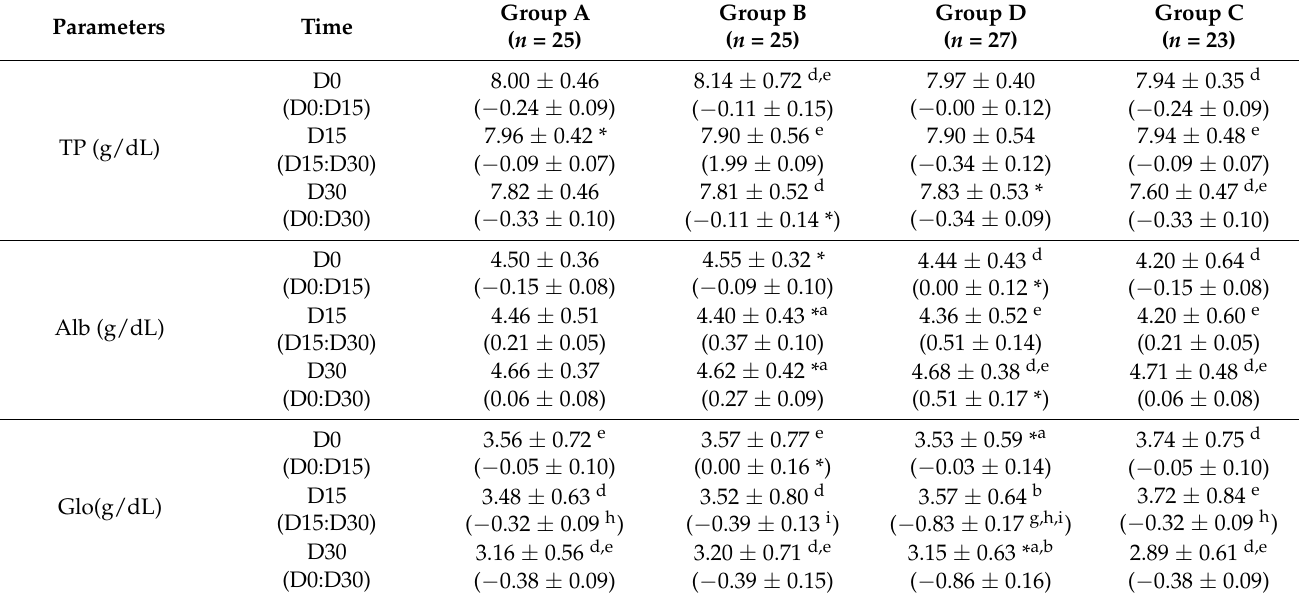
Table 5. Levels of serum proteins, aspartate aminotransferase and alanine aminotransferase activity of non-anemic subjects who consumed the WR drink (2 mg iron/100 mL serving) (group A), IR drink (15 mg iron/100 mL serving) (group B) and (group C) for 30 days. Data are expressed as mean ± SD values. Changes in the mean are shown as mean ± SD values in the